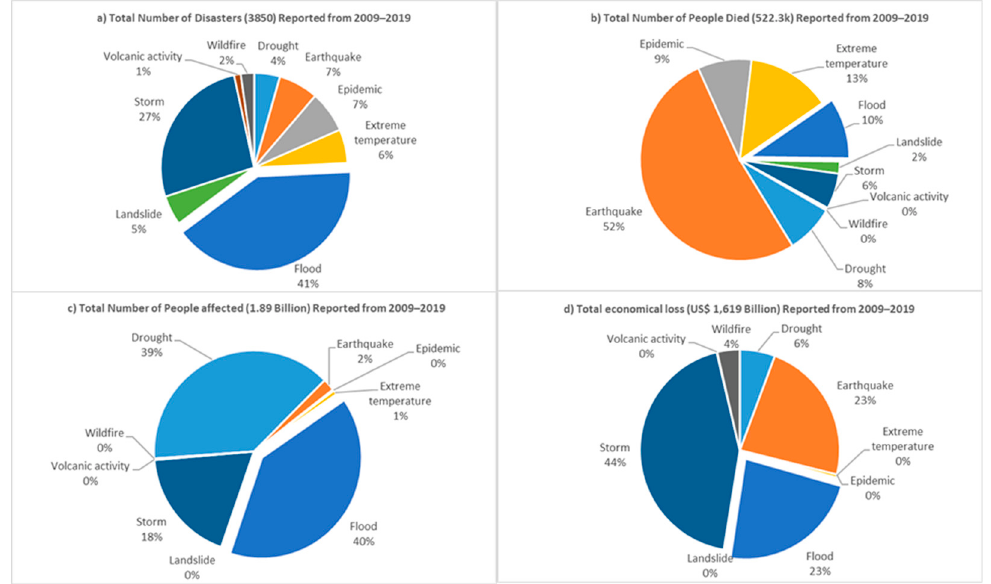
Figure 1. Comparison of different disaster types reported from 2009 to 2019: ( a ) total number of reported disasters; ( b ) total number of deaths; ( c ) total number of people affected; and ( d ) total economic loss [4].